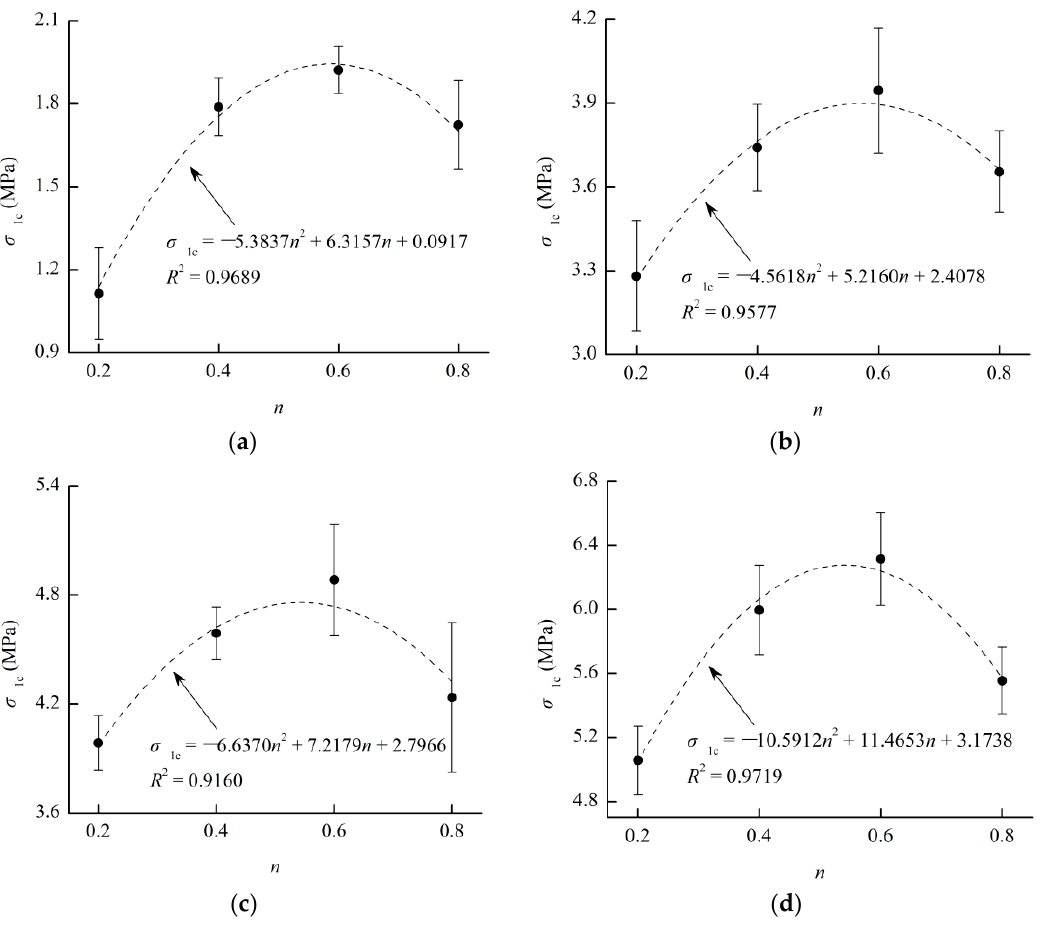
Figure 9. Relationship between the peak strength and Talbot index of CPB specimens under different confining pressures. σ 3 = 0 MPa ( a ); σ 3 = 0.5 MPa ( b ); σ 3 = 1 MPa ( c ); σ 3 = 2 MPa ( d ). Table 5. Relationships between the peak strength and Talbot index of CPB specimens under different confining pressures.